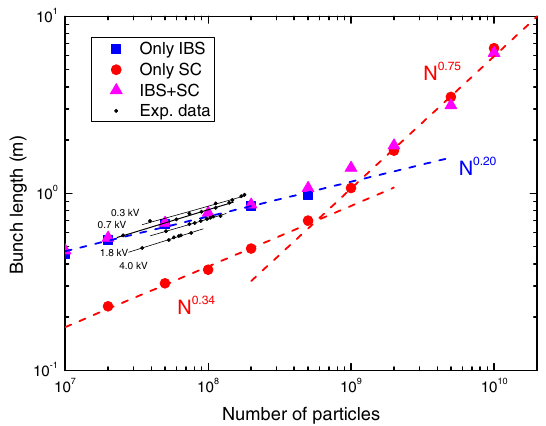
FIG. 8. The bunch length versus particle number in the simulation (colored) and experiment (black) for 6 . 9 MeV = u 12 C 6 þ ion beam. In the simulation, the bunch length is estimated by considering the effects of IBS and space charge independently. The dashed lines are fitted to the simulation